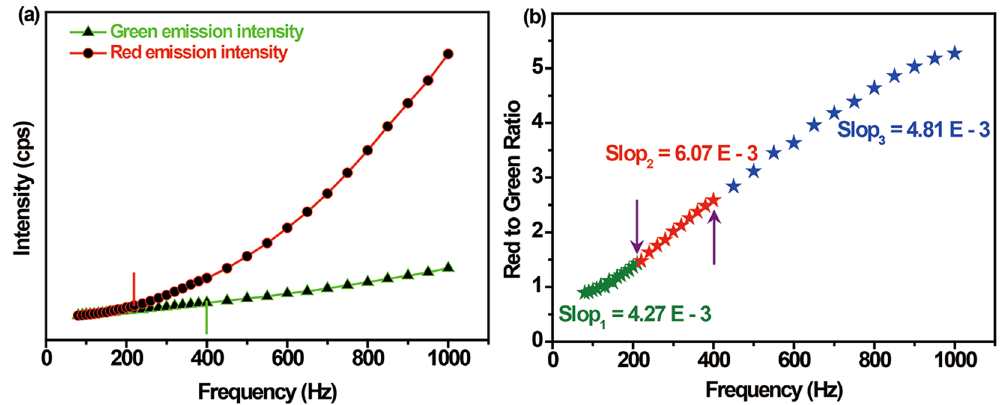
Figure 5. The effect of repetition frequency on upconversion emission. ( a ) The green emission at 541 nm and red emission at 654 nm intensity; ( b ) Red-to-green ratio dependence on repetition frequency when the pulse duration is fixed as 500 µ